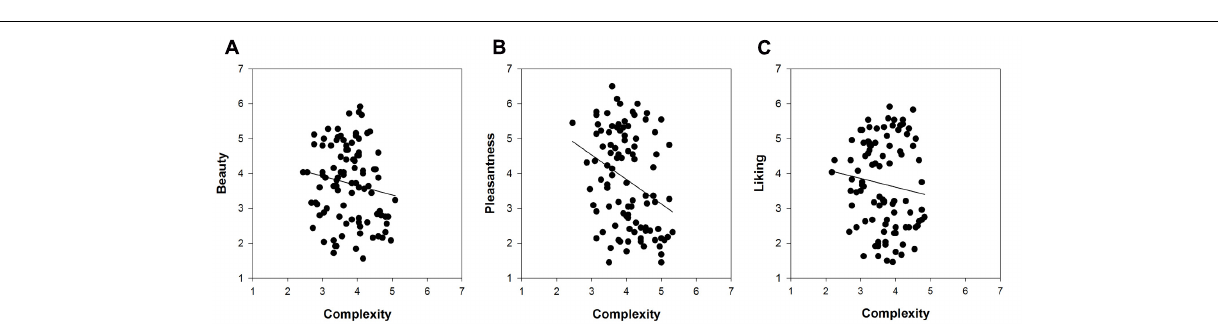
FIGURE 3 | The relationships between complexity and the three measures of hedonic tone for 96 cartoons based on IAPS pictures: (A) beauty, (B) pleasantness, and (C) liking.